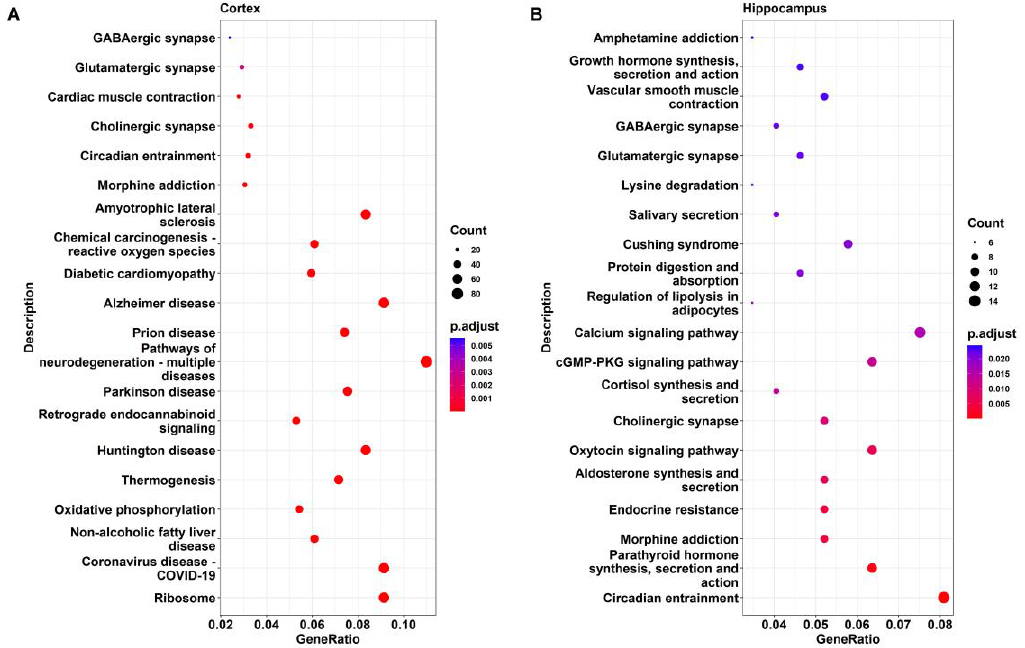
Figure 6. KEGG pathway analysis of the DEGs in the cerebral cortex ( A ) and hippocampus ( B ) of male DAPK1-KO mice.